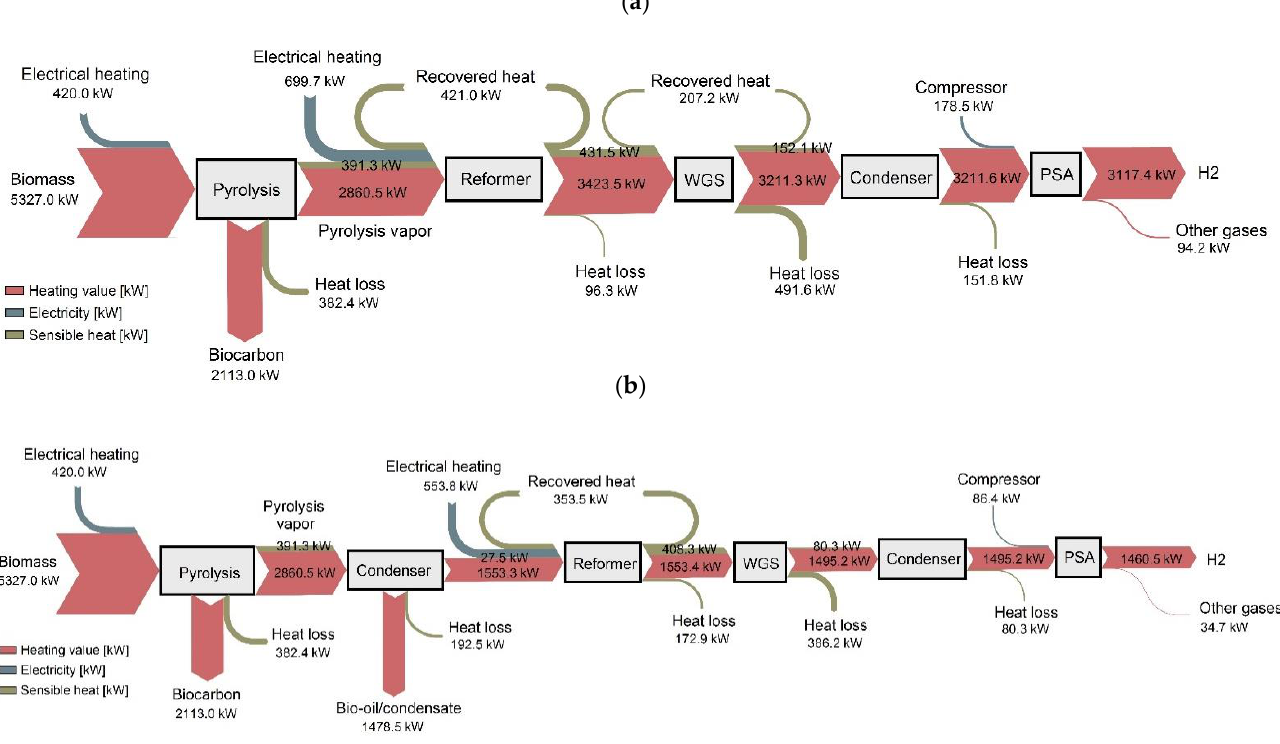
Figure 7. Energy flow diagrams for production scheme of ( a ) biocarbon and H 2 (Scheme 1); and ( b ) biocarbon, bio-oil, and H 2 with condenser temperature of 50 °C (Scheme 2).